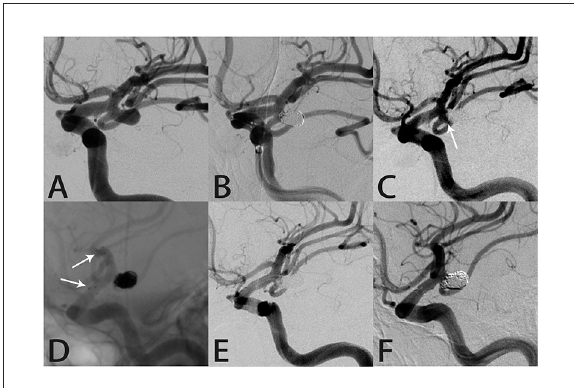
FIGURE1 Images from a 65-year-old man with a left posterior communicating artery aneurysm (case 1). (A) Preoperative angiography showed a left posterior communicating artery aneurysm. (B) The aneurysm was occluded completely after coil embolization. (C) Follow-up angiography 21 months after the procedure revealed a mild recurrence in the aneurysm neck (white arrow). (D) Angiography during re-treatment showed the deployed Atlas stent (3.0 × 21mm) covering the aneurysm neck and coils densely packed within the sac (white arrow indicates the end of the stent). (E) Angiography immediately after the procedure showed the aneurysm was occluded completely. (F) Follow-up angiography 10 months later showed complete aneurysmal occlusion and parent artery